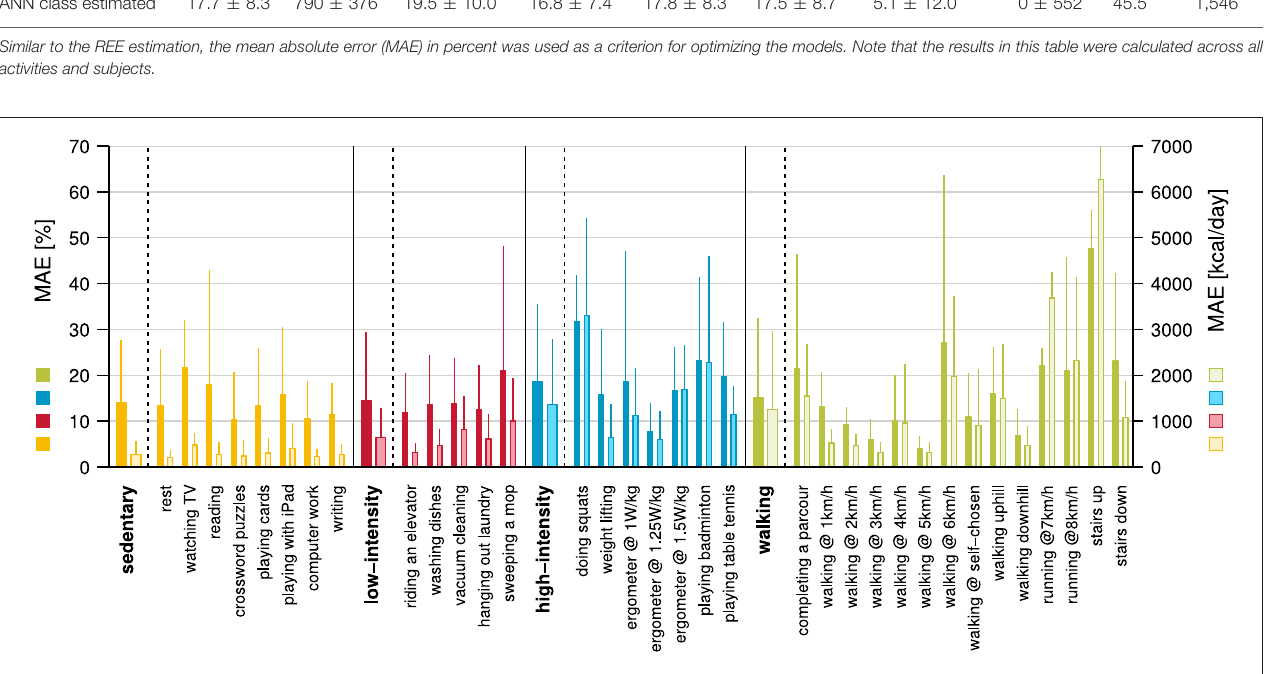
FIGURE 4 | Mean absolute error (MAE) in percent (dark colors) and kcal/day (bright colors) for the EE estimation using the MLR based model with preceding activity classification. The overall MAE for this model was 15.2 ±